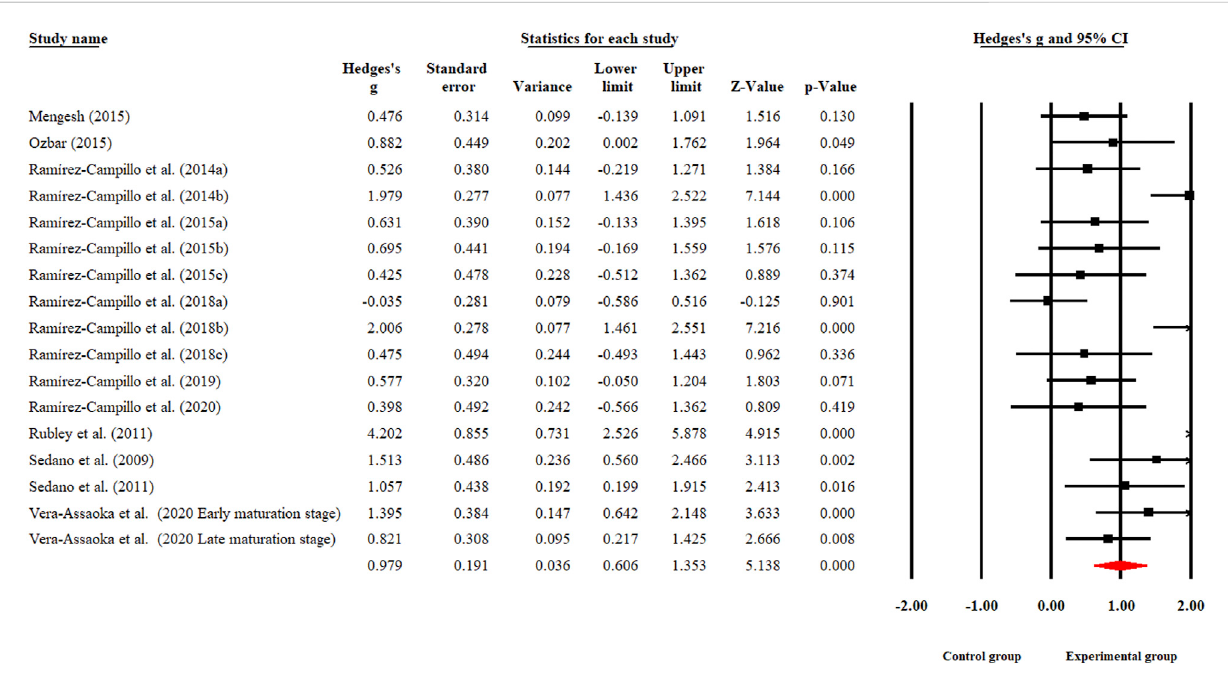
FIGURE 2 Forest plot of kicking performance in soccer players participating in plyometric training compared to the control group.